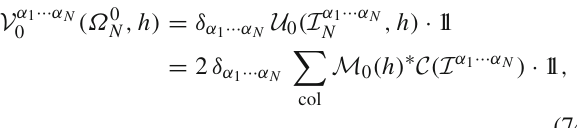
,..., S α N are merged into a single open N 3